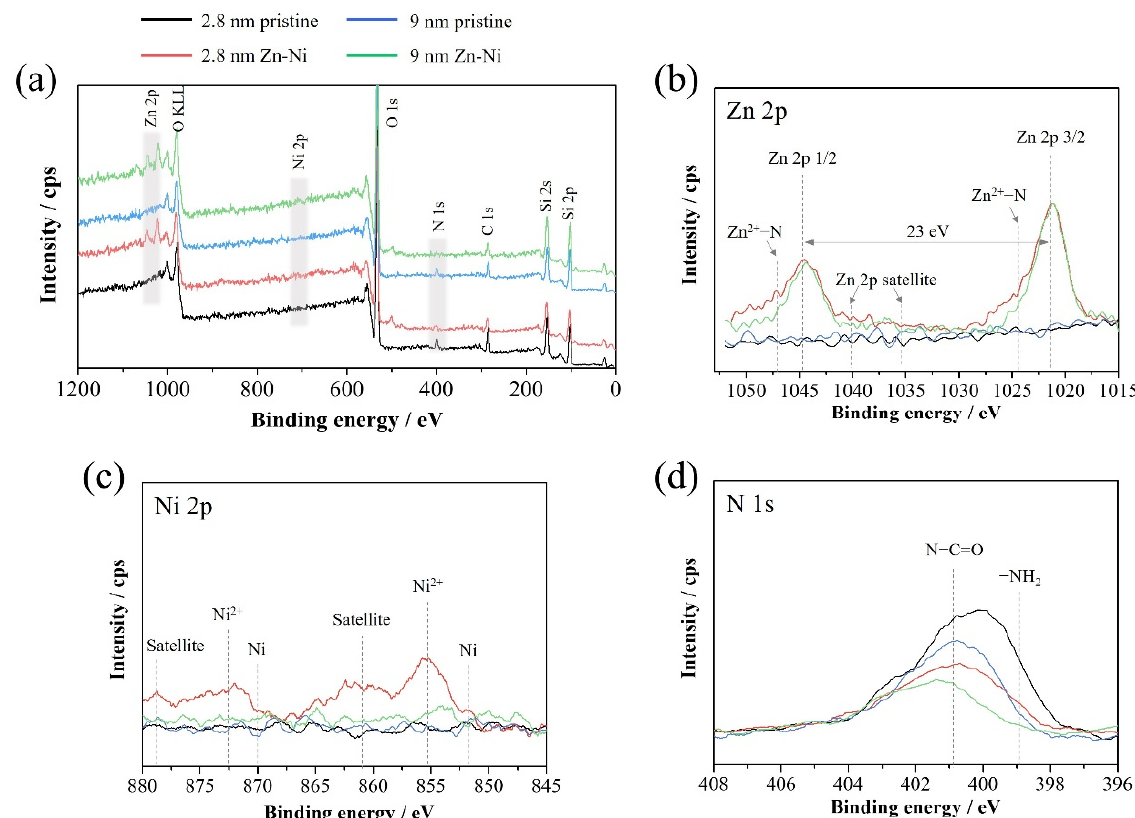
Figure 14. XPS survey spectra of the amine-modified MS prepared from MSs with initial pore sizes of 2.8 nm and 9 nm ( a ), and core-level spectra for Zn 2p ( b ), Ni 2p ( c ), and N 1s ( d ) in the Zn–Ni binary system.